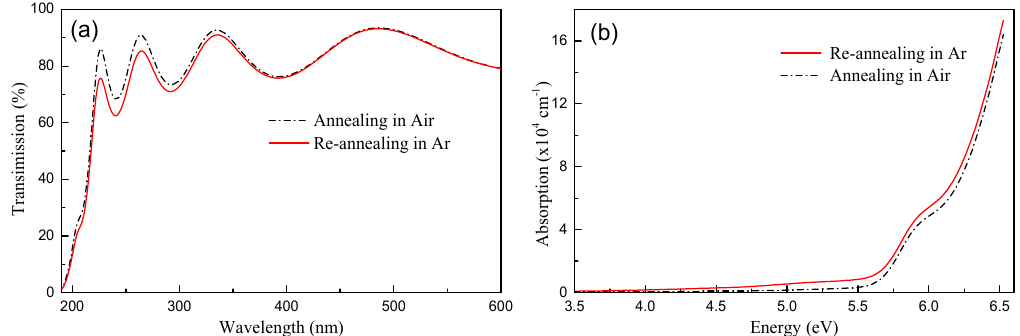
Figure 5. The ( a ) transmission and ( b ) absorption of EBD HfO 2 films before and after annealing under Ar gas.